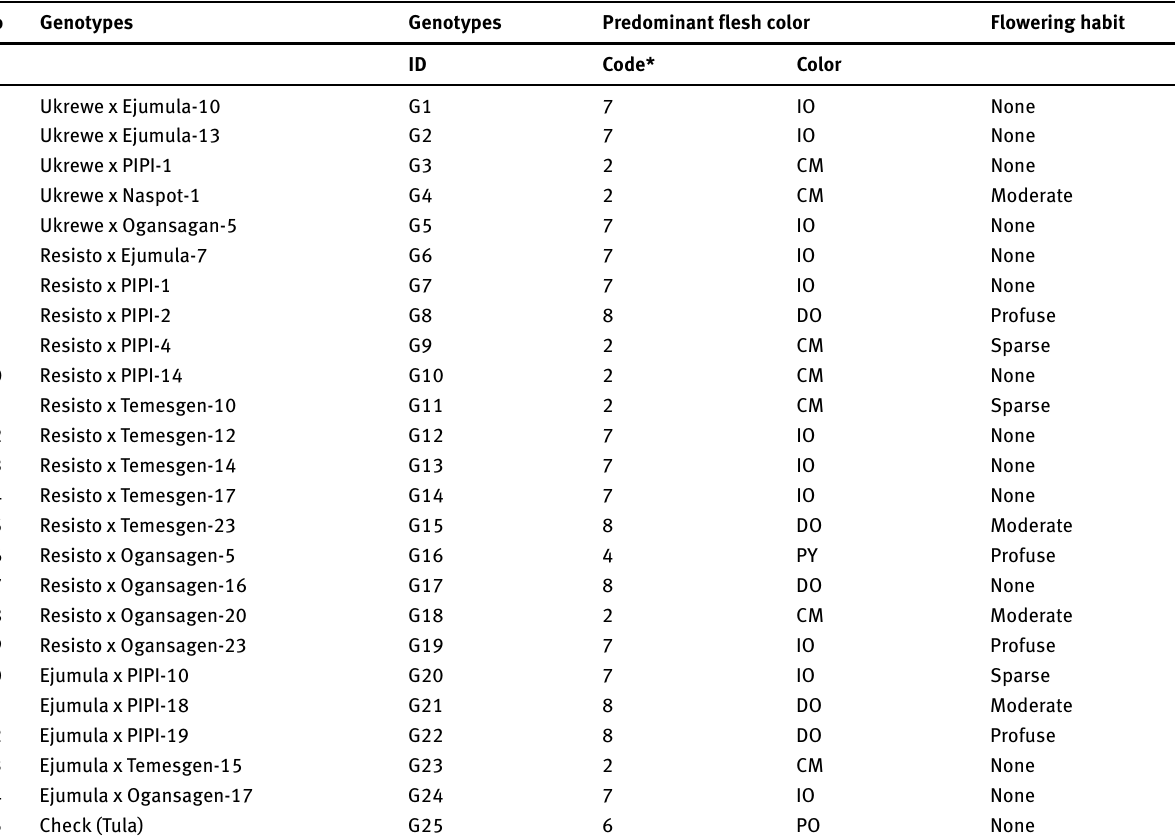
Table 2: Description of sweetpotato genotypes used for the study No Genotypes Genotypes